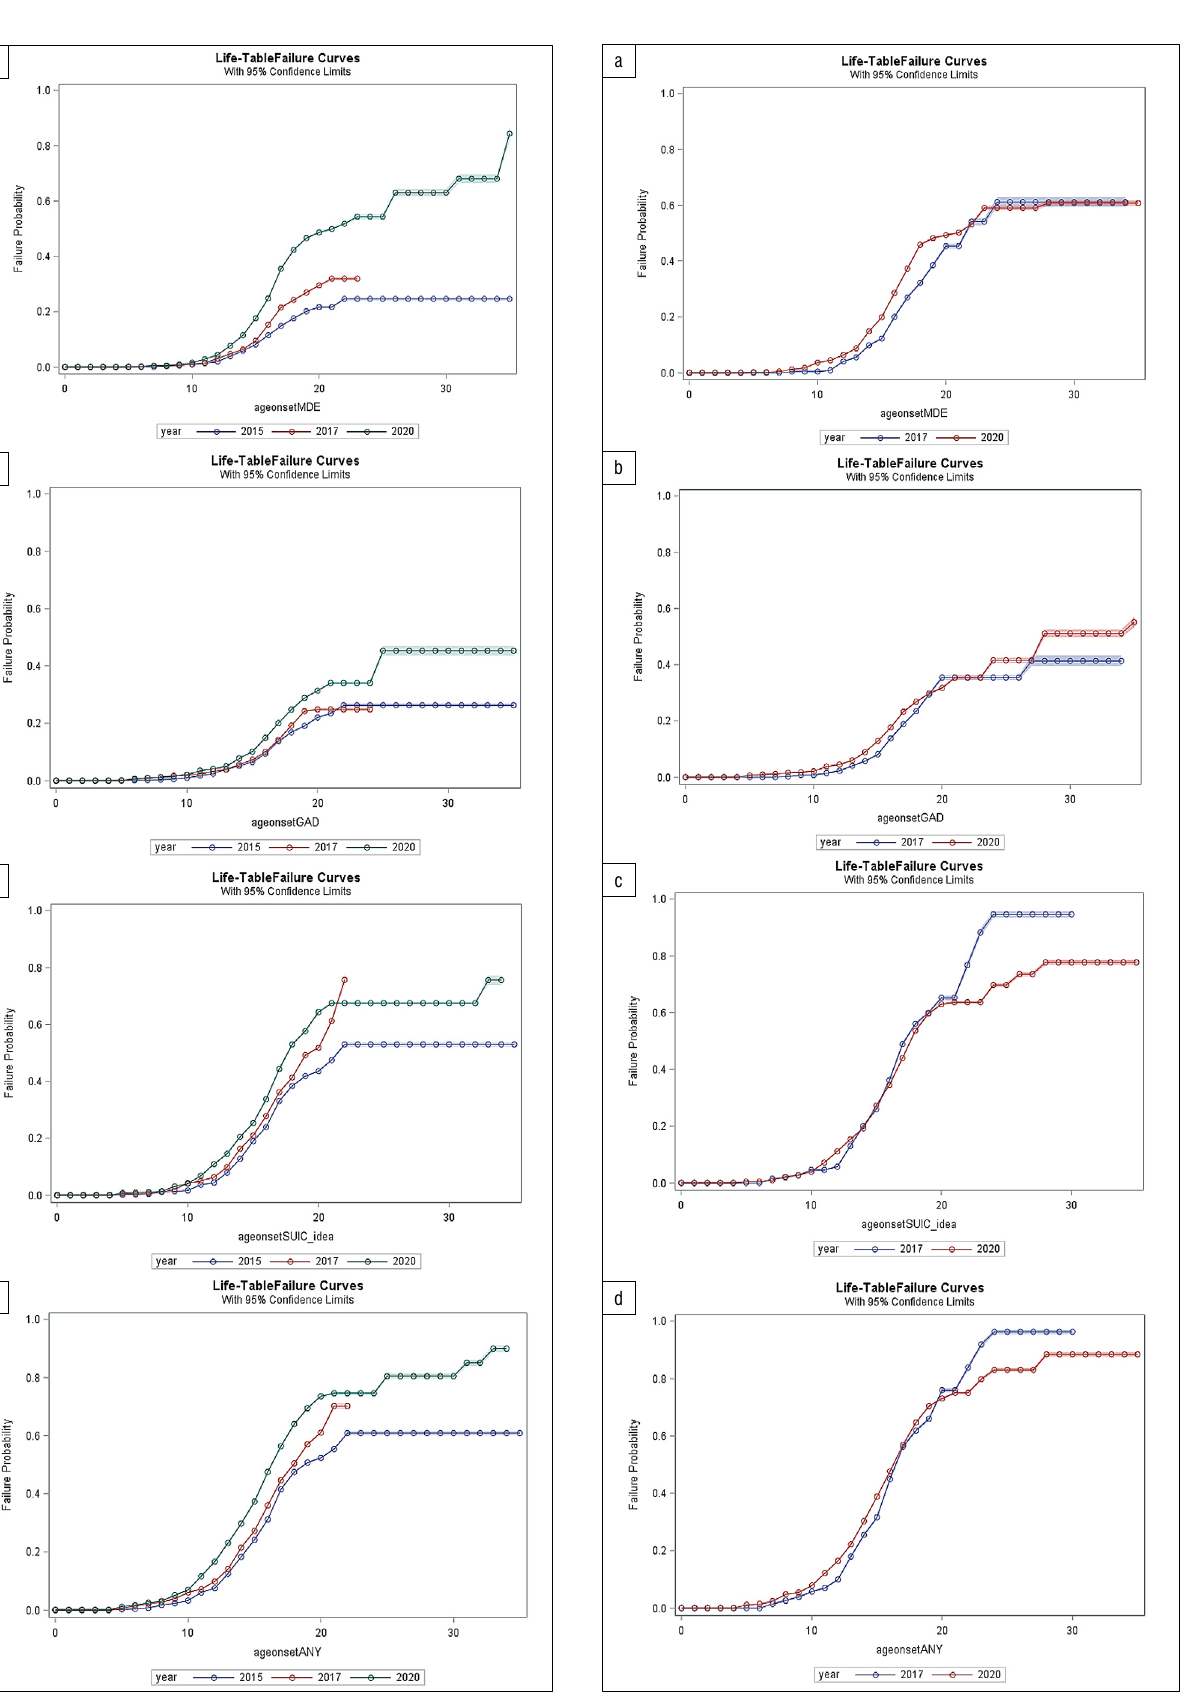
Figure 2: Age of onset curves up to age 24 for (a) major depressive episode (MDE), (b) generalised anxiety disorder (GAD), (c) suicidal ideation, and (d) any of these outcomes among